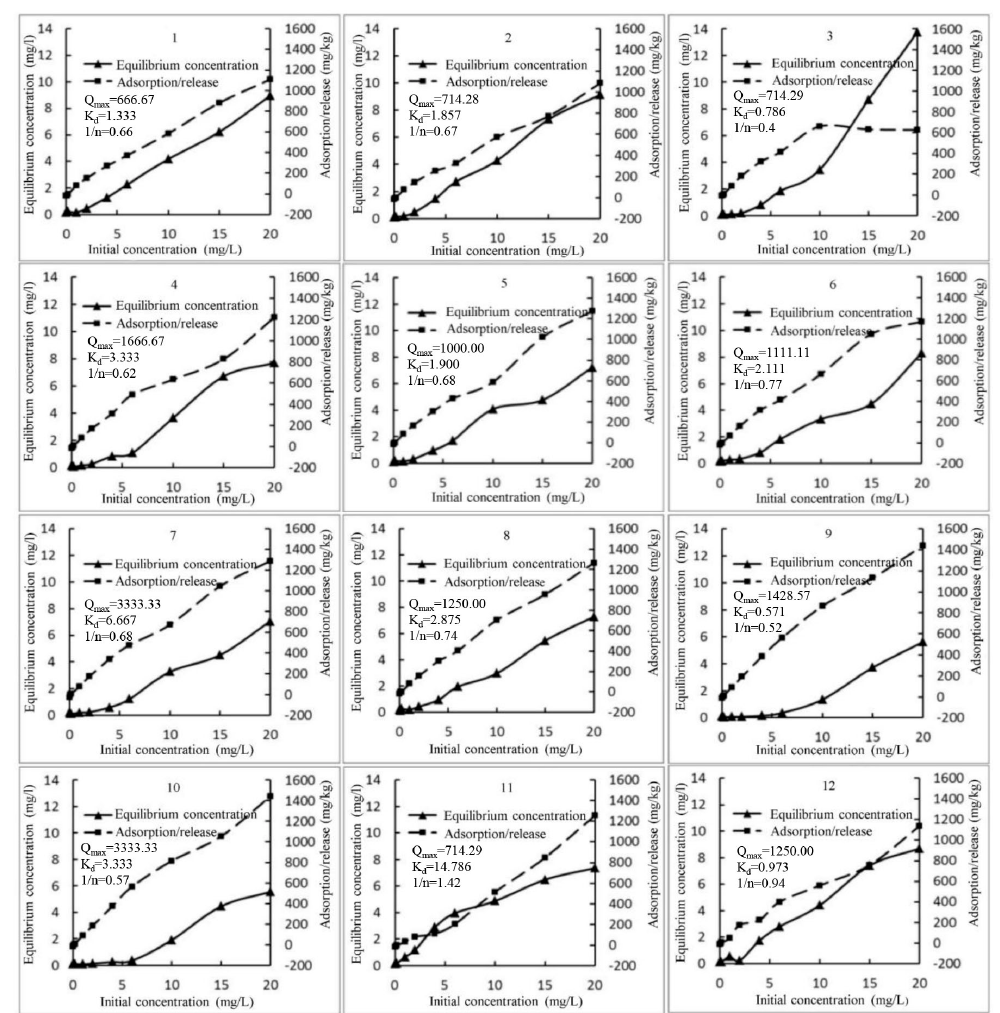
Figure 2. The characteristics of P adsorption and release in sediments.